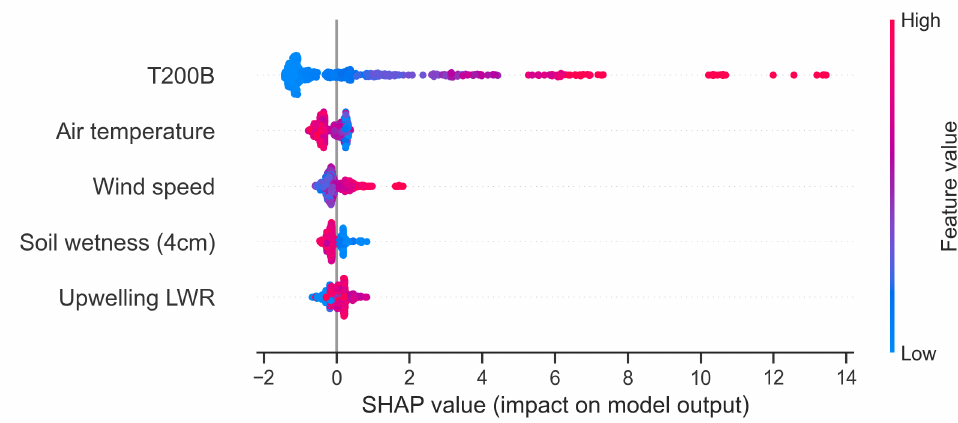
Figure 7. The SHAP value of the selected five variables. Each line in the graph represents a feature, and the horizontal coordinates are SHAP values. A dot represents a sample. The redder the color, the larger the value of the feature itself. The bluer the color, the smaller the value of the feature